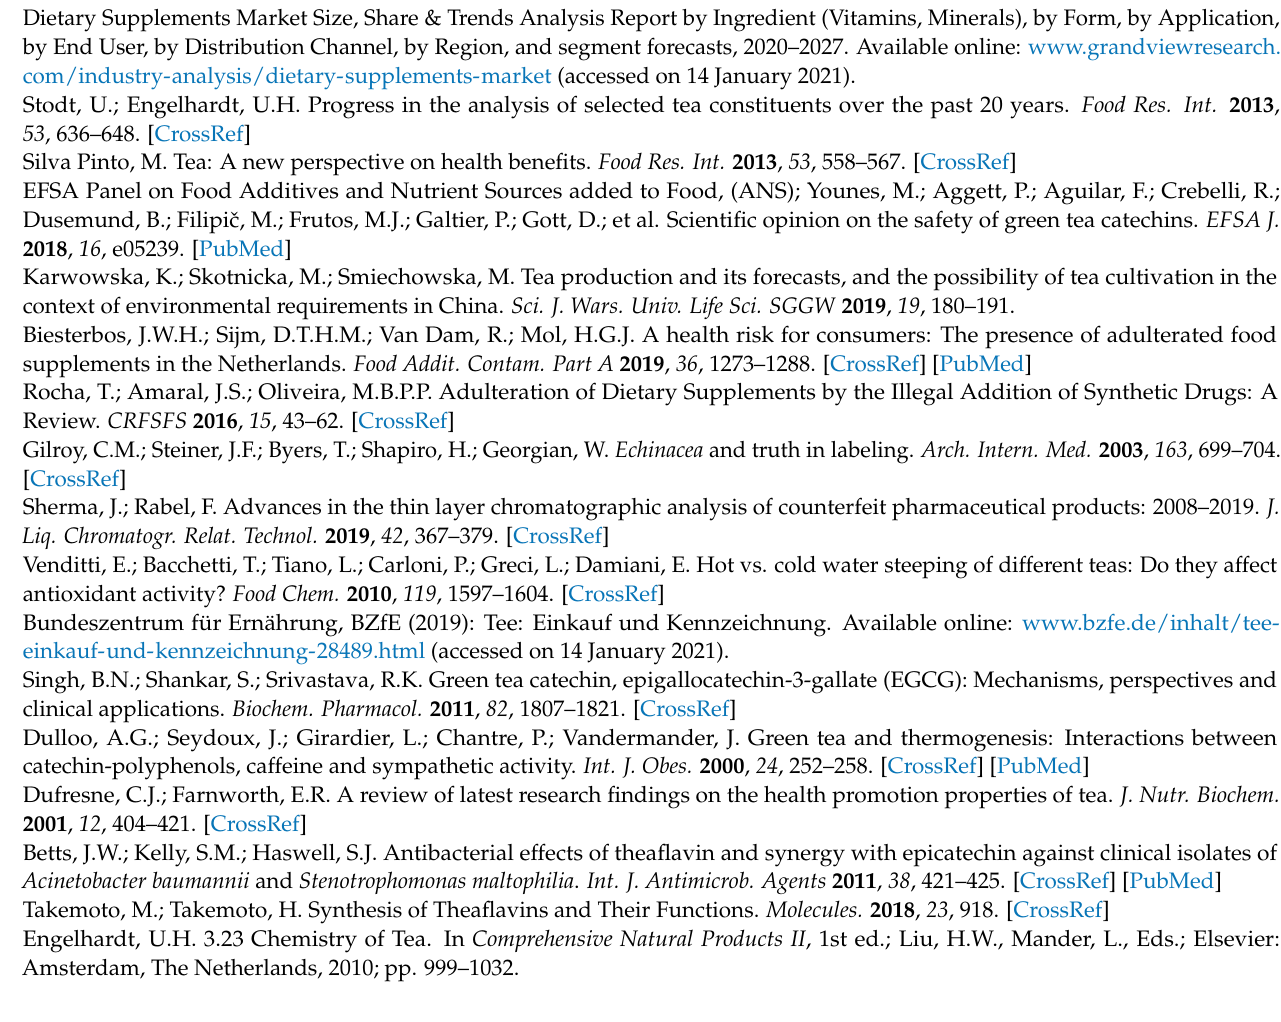
Figure S1: Images of the investigated 20 Camellia sinensis samples (powders and leaves), Figure S2: HPTLC–UV/FLD chromatograms of the separation for different sample amounts, Figure S3: Assign- ment of the 10 flavonoid zones, Figure S4: UV/FLD response enhancement on the buffered plate, Figure S5: Overlaid UV 275 nm densitograms obtained directly and up to 3 h on the buffered plate, Figure S6: Observations during the development of the B. subtilis bioassay on the LiChrospher ®